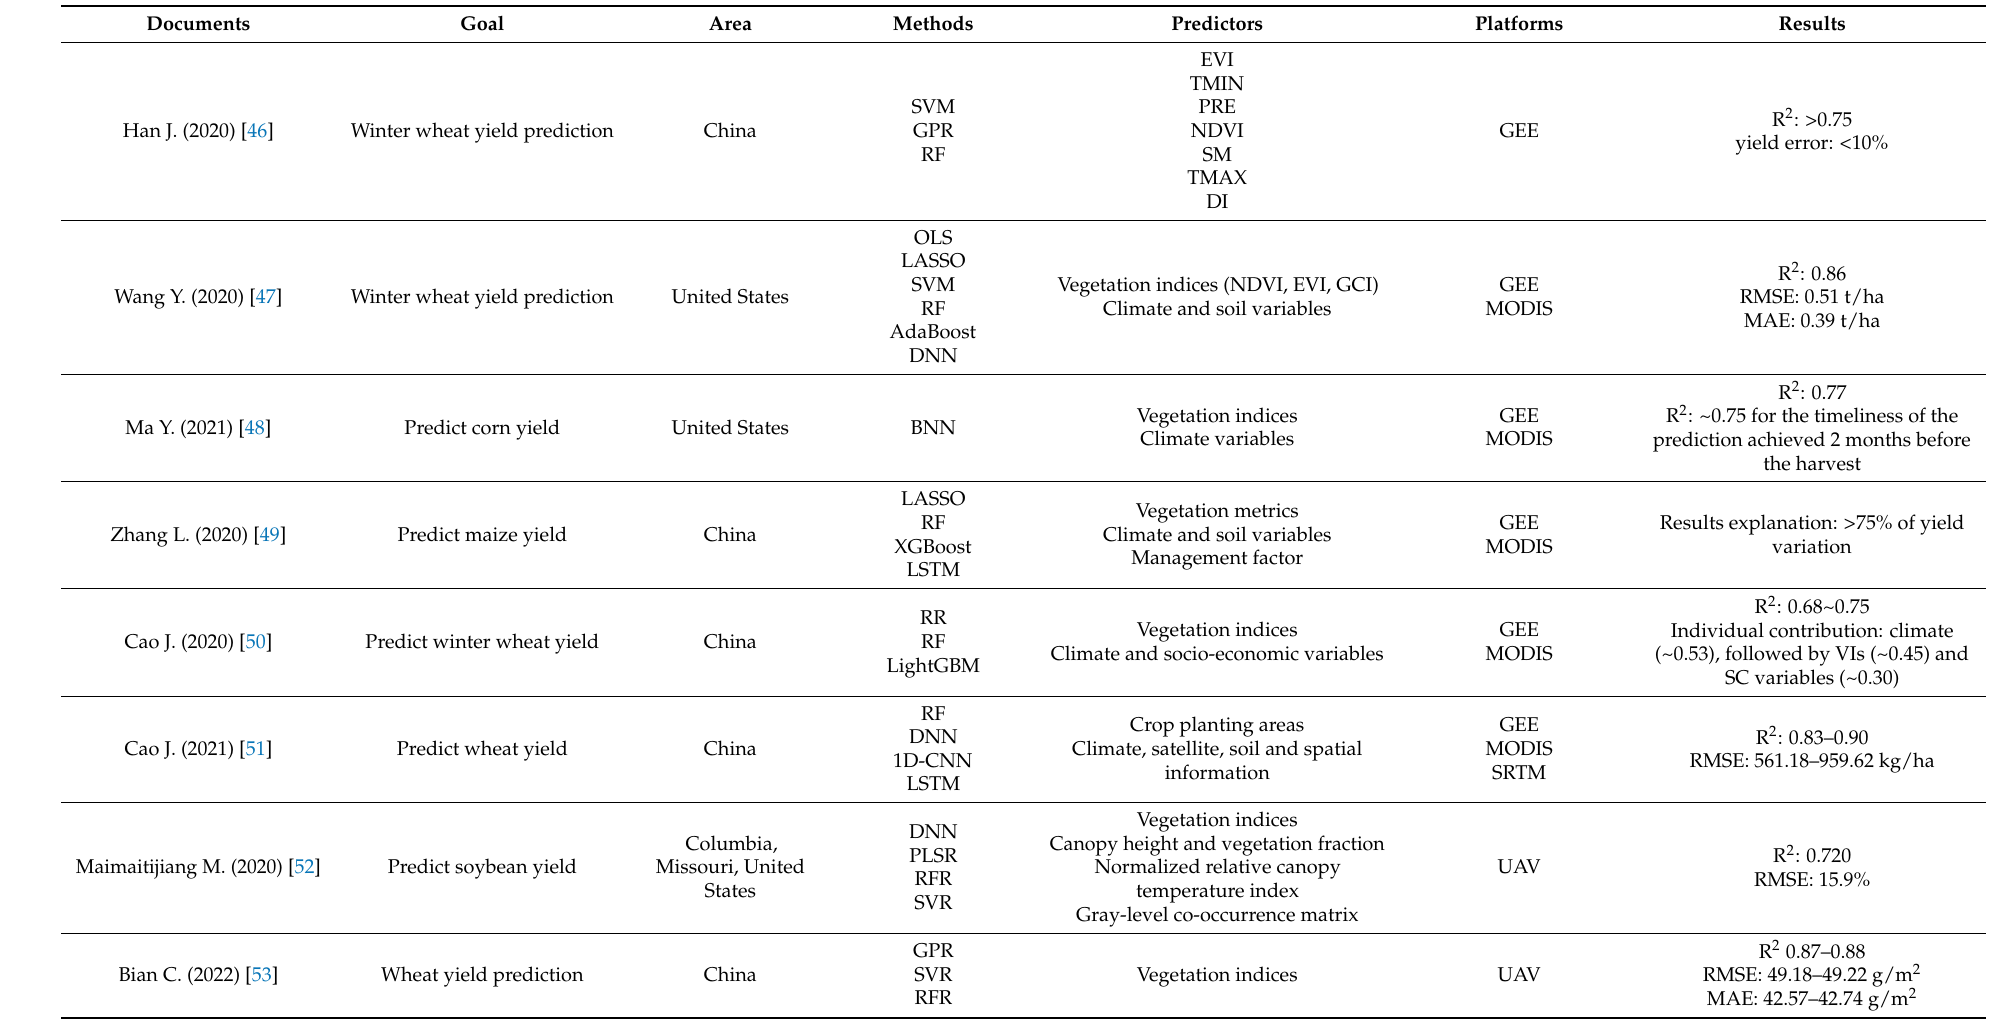
Table 7. Summary insights from the systematic